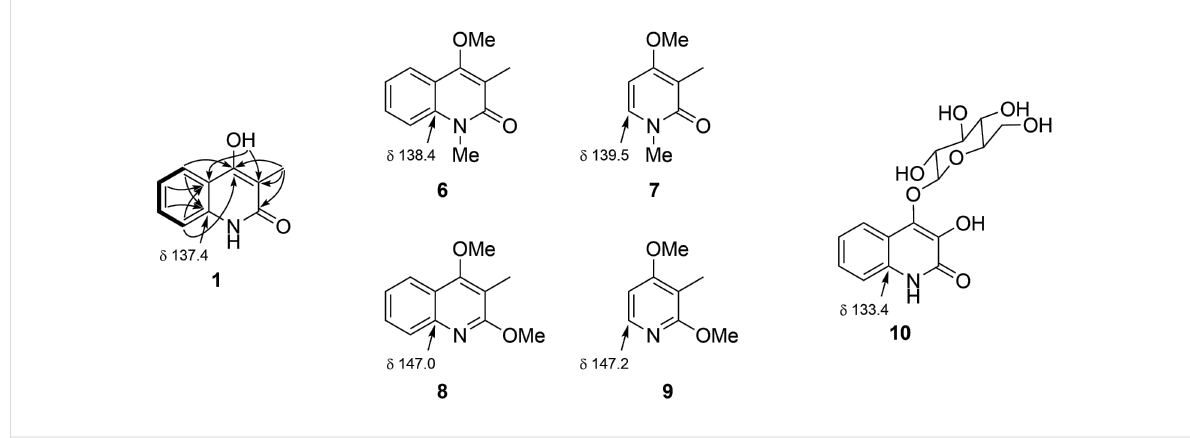
Figure 2: COSY-deduced spin-system (bold lines) and key HMBC correlations (arrows) for compound 1 , and structures for compounds 6 – 10 with a 13 C chemical shift at the C8a position.